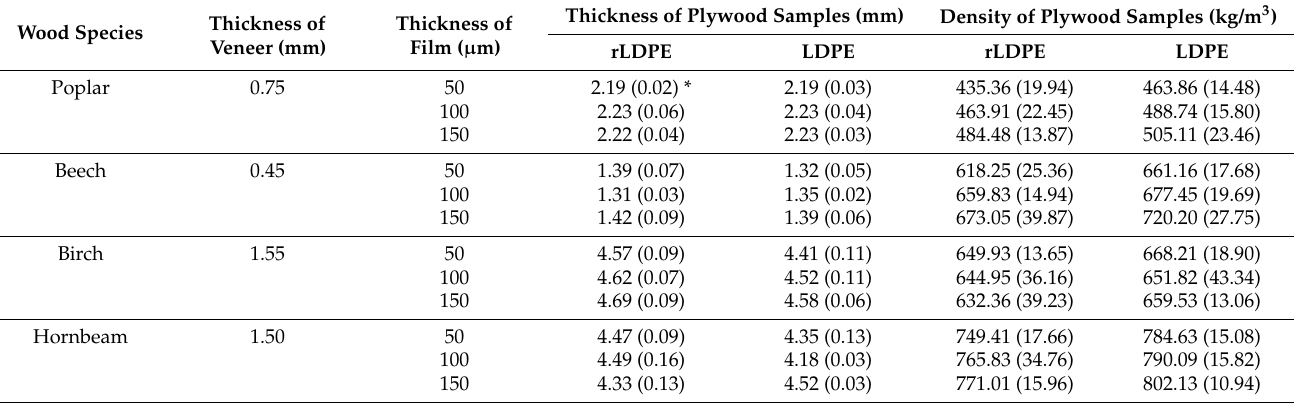
Table 1. Thickness and density of plywood